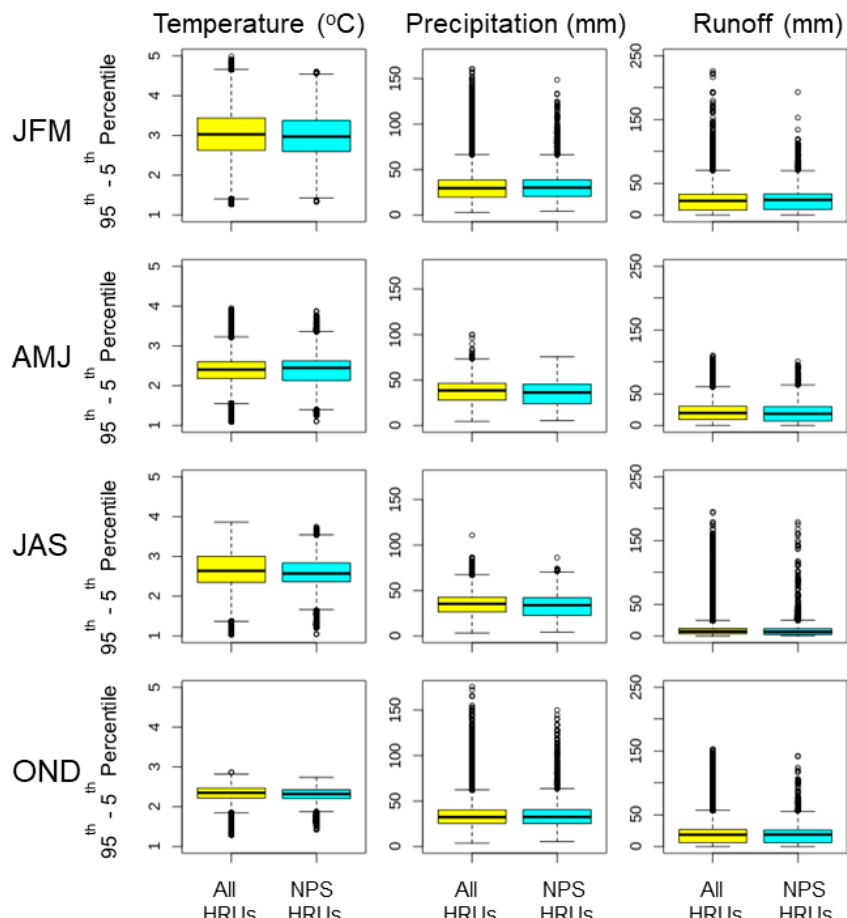
Figure 9. Boxplots comparing projected ranges (95th percentile − 5th percentile) of departures in seasonal average monthly temperature in degrees Celsius ( ◦ C), precipitation in millimeters (mm), and runoff in mm projected for 2030 from 214 climate simulations, for all HRUs in the CONUS (yellow) with only HRUs in national parks (NPS; cyan). HRU, Hydrologic response unit; JFM, January–March; AMJ, April–June; JAS, July–September; OND, October–December. The shaded boxes show 25th–75th percentile of projected ranges. The line across the box shows the median projected range. The whiskers extend to the largest value that is less than the 75th percentile value plus 1.5 times the interquartile range (75th percentile–25th percentile) and to the smallest value that is greater than the 25th percentile value minus 1.5 times the interquartile range. Outliers are shown as circles.